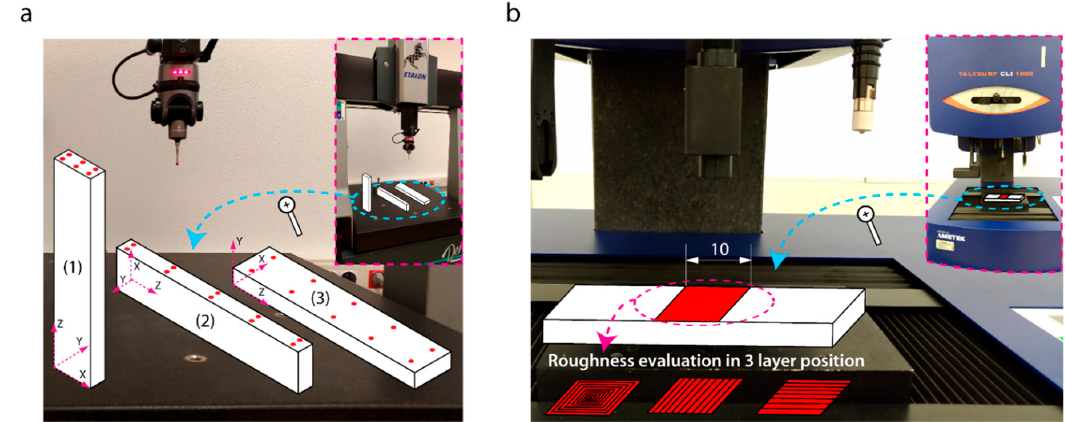
Figure 2. Experimental measurement setup: ( a ) Detail of the dimensional deviation measurement procedure for upright orientation workpiece; ( b ) detail of the flatness, topography, and roughness evaluation procedure for the three building orientations.